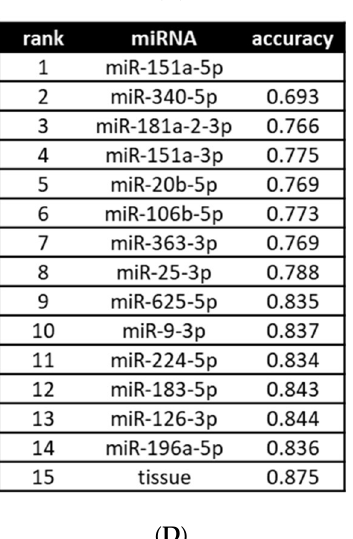
Figure 4. MiRNA expression as a classifier to distinguish 4 subtypes of small B-cell lymphoma. ( A ) Confusion matrix based on the average classification performance of four lymphoma subtypes in the test datasets of 100 iterations of four-fold cross-validation. ( B ) Performance comparison between three algorithms (random forest, SVM with linear kernel and SVM with radial kernel) in training the classification model. ( C ) Classification accuracy for distinguishing between the four subtypes with respect to the increasing number of miRNA features included in the classification model. ( D ) Top 14 miRNAs and tissue information that achieves 87.5% classification accuracy for four lymphoma subtypes. Abbreviations: SLL, small lymphocytic lymphoma/chronic lymphocytic leukemia; CLL, chronic lymphocytic leukemia; FL, low-grade follicular lymphoma; MCL, mantle cell lymphoma; MZL, marginal zone lymphoma; RL, reactive lymphoid proliferations.